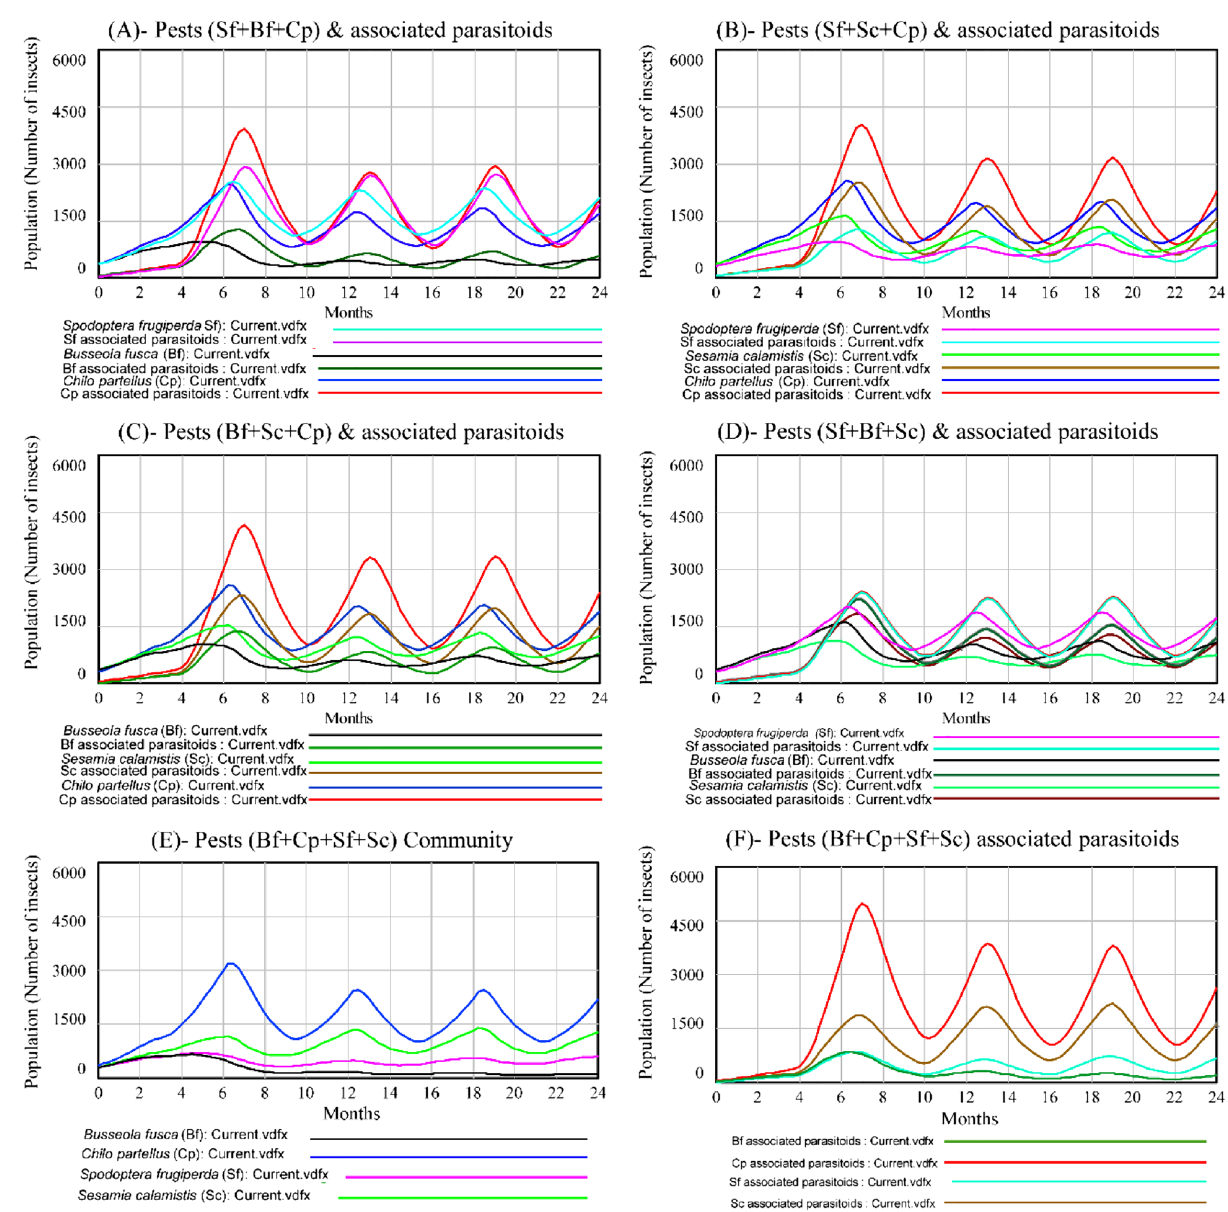
Figure 3. Populations of Chilo partellus , Busseola fusca , Sesamia calamistis and Spodoptera frugiperda and their associated parasitoids in three and four multi-species competitive systems. Three multi-species: ( A ) S. frugiperda + B. fusca + C. partellus (Sf + Bf + Cp); ( B ) S. frugiperda + S. calamistis + C. partellus (Sf + Sc + Cp); ( C ) B. fusca + S. calamistis + C. partellus (Bf + Sc + Cp) and ( D ) S. frugiperda + B. fusca + S. calamistis (Sf + Bf + Sc) systems. Four multi-species: ( E ) B. fusca + C. partellus + S. calamistis + S. frugiperda (Bf + Cp + Sc + Sf) and ( F ) their associated parasitoids populations grew faster than their respective host populations. Din and Donchev 42 reported that in a host-parasite interaction, if a host population is a pest, then according to the Leslie–Gower model, a fast-growing parasite population with a growth rate larger than that of the host significantly reduces the host population. Therefore, the present model indicates a significant effect of parasitoid on stemborers population regulation. Despite high outbreaks reported for S. frugiperda , its population dynamics in our single-species system was actually the lowest which might be due to its high cannibalism rate reported in the literature 43,44 and also because the high outbreaks across SSA was reported during the first months of infestation when equilibrium was not yet established; whereas stemborers have been present for decades. Within stemborer species in multi-species systems (either in two or three species systems), C. partellus exhib- ited dominance whenever involved in a system. Several previous studies have reported the dominance of C. par- tellus over B. fusca and S. calamistis when they co-exist 15,19,24 . In two-species system with C. partellus and B. fuca , the model showed that C. partellus has displaced B. fusca population with time. Those competitive interactions